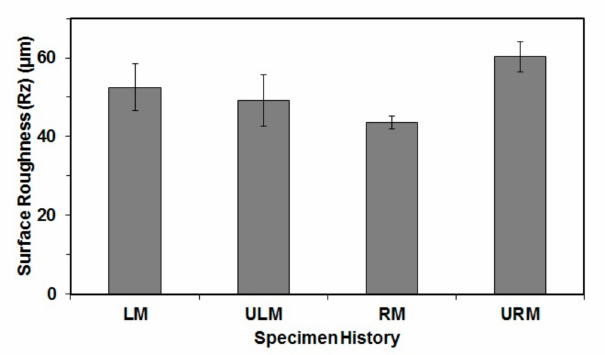
Figure 5. Surface roughness ( R z ) of laser clad Al-SiC composite surface processed with different laser processing